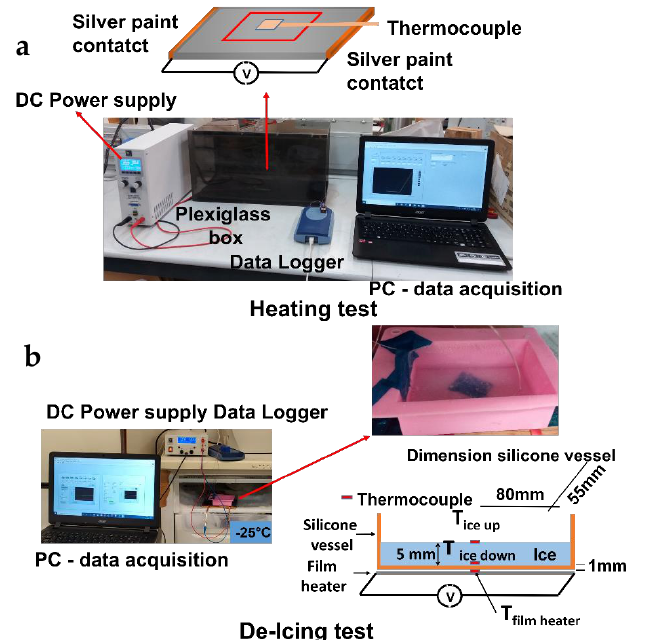
Figure 2. Heating measurement layout: ( a ) schematic representation of the heating tests and ( b ) configuration of the de-icing tests.